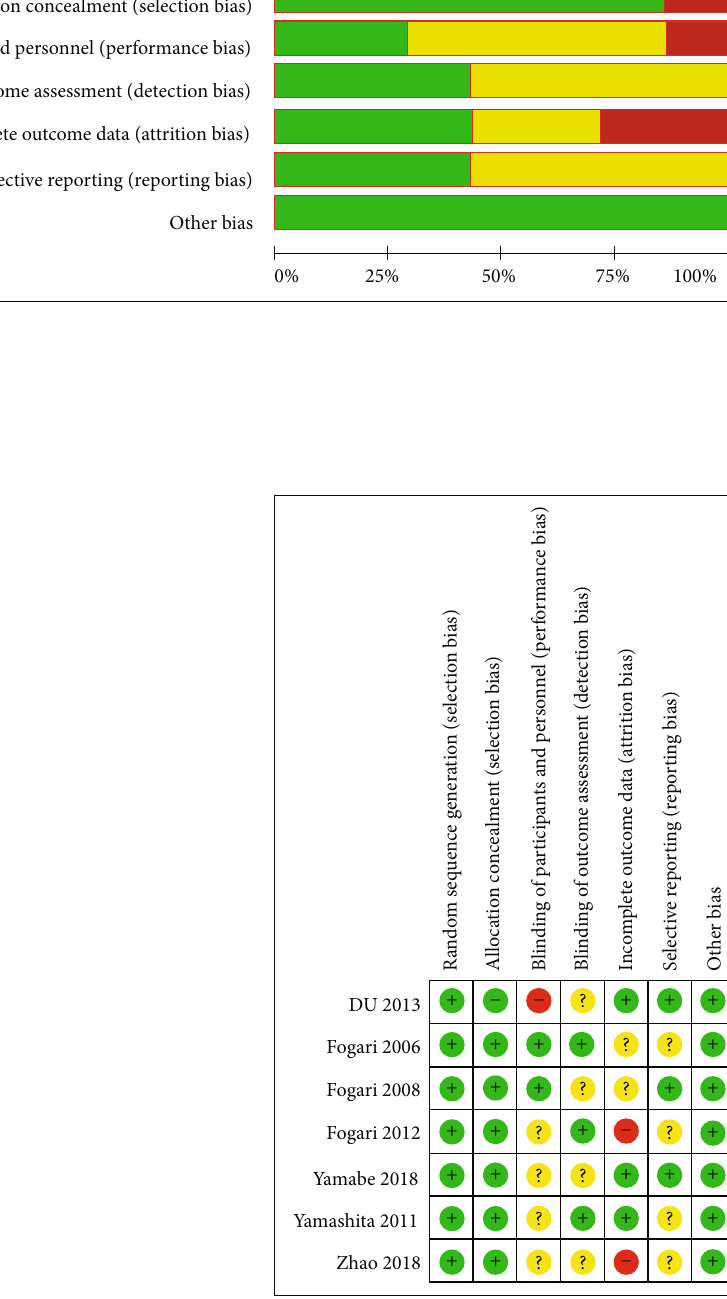
Figure 1: Risk bias assessment using the Cochrane risk of bias